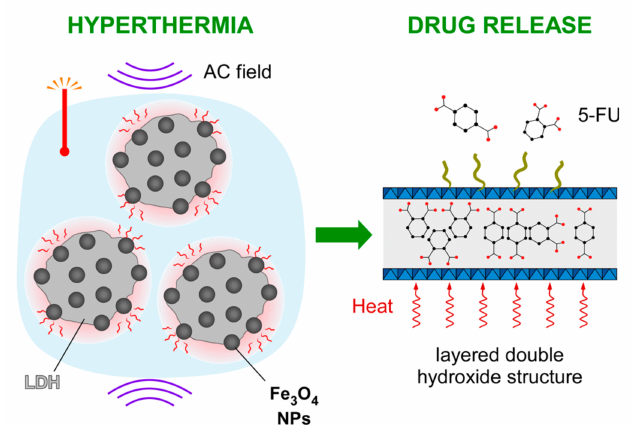
Figure 1. Graphical concept of controllable 5-fluorouracil release from the Fe 3 O 4 /Mg-Al LDH nanocomposite when exposed to a radiofrequency AC magnetic